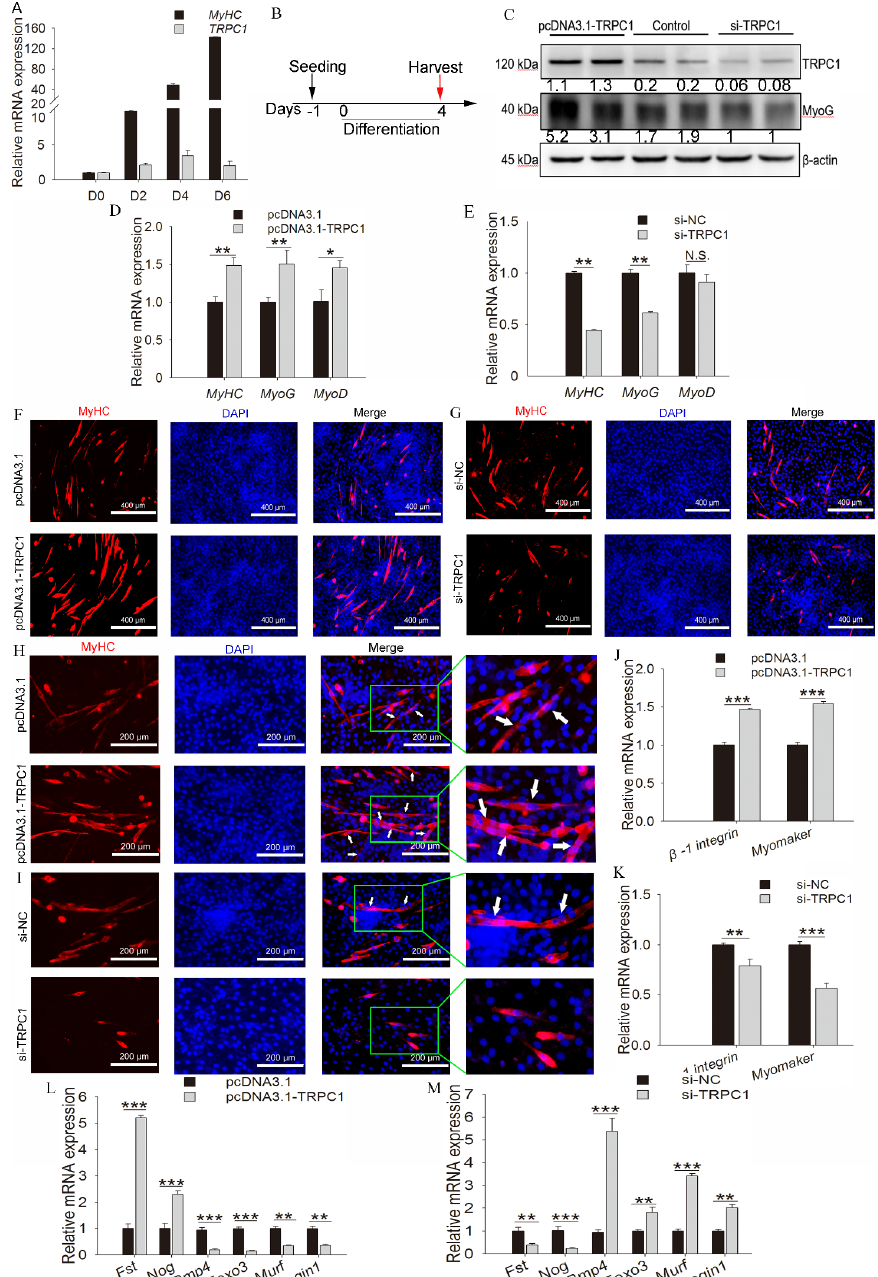
Figure 4. TRPC1 promoted cell fusion, differentiation, and muscle hypertrophy but inhibited muscle degradation. ( A ) qRT- PCR results showed the expression profiles of the TRPC1 gene during differentiation. MyHC is the myogenic differentiation marker gene. ( B ) Schematic of cell differentiation time. ( C ) The protein level of TRPC1 and differentiation marker MyoG. ( D , E ) The mRNA expression of differentiation marker genes MyoD , MyoG , and MyHC quantified by qRT-PCR. ( F,G ) Immunofluorescence staining for MyHC protein in control or pcDNA3.1- TRPC1 /si- TRPC1 -treated myoblasts cultured for 4 days in differentiation medium. MyHC protein expression is shown in red, and nuclei in blue (DAPI). White scale bar = 400 µ m. ( H , I ) Myoblast fusion analysis by immunofluorescence staining for MyHC, and the arrows represent the multinucleated myotubes, white scale bar = 200 µ m. ( J , K ) The mRNA expression of fusion marker genes quantified by qRT-PCR. ( L , M ) The mRNA expression of muscle degradation markers ( Atrogin1 , Bmp4 , Murf , and Foxo3 ) and muscle hypertrophy genes ( Fst and Nog ) quantified by qRT-PCR ( n = 3, respectively). NC: negative control. The data represent the means ± SD of three independent experiments. N.S.: not significant, * P < 0.05, ** P < 0.01, *** P <